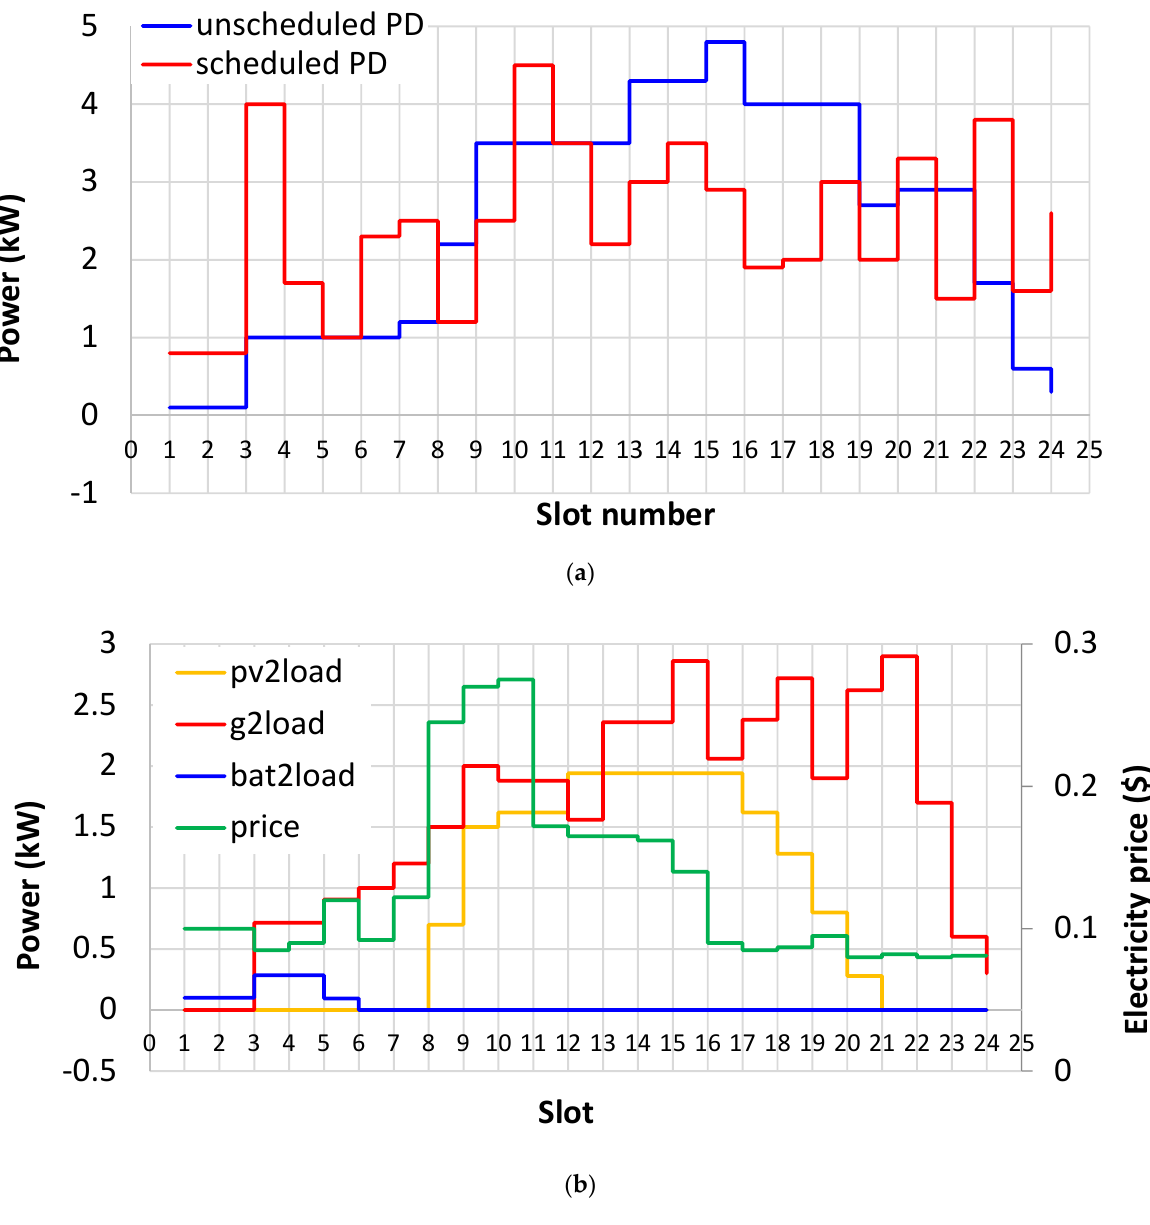
Figure 8. ( a ) The scheduled and unscheduled daily power demand, and ( b ) the powers delivered to the load.pv2load, PV to load; bat2load, battery to load; g2load, grid to load; price, electricity price in $.